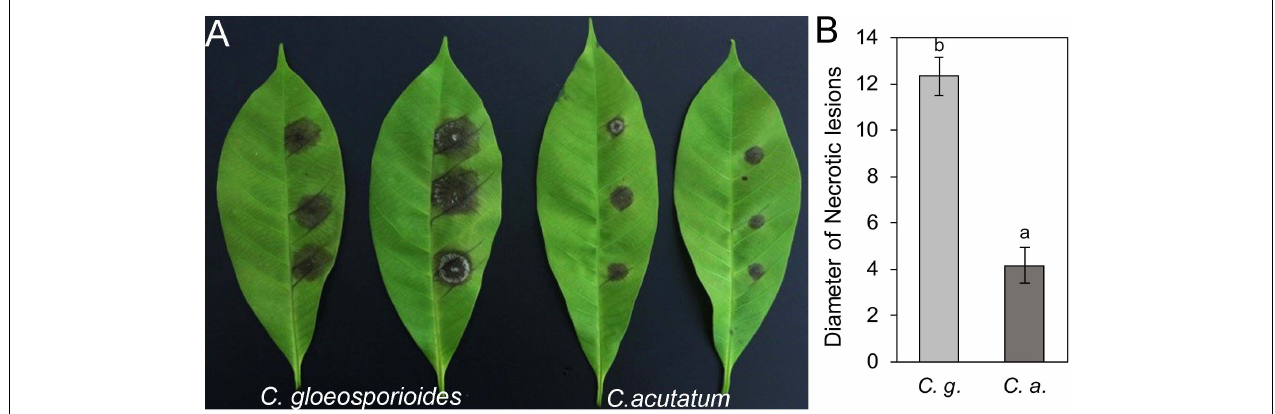
FIGURE 1 | Pathogenicity assay of Colletotrichum gloeosporioides Hb and Colletotrichum acutatum Hb on rubber tree leaves. (A) Disease symptoms of rubber-tree leaves at 3 days post-inoculation with C. gloeosporioides Hb and C. acutatum Hb mycelium. (B) Lesion diameters at 3 day post-inoculation. Error bars indicated standard deviation, and columns with different letters indicate significant difference ( P <